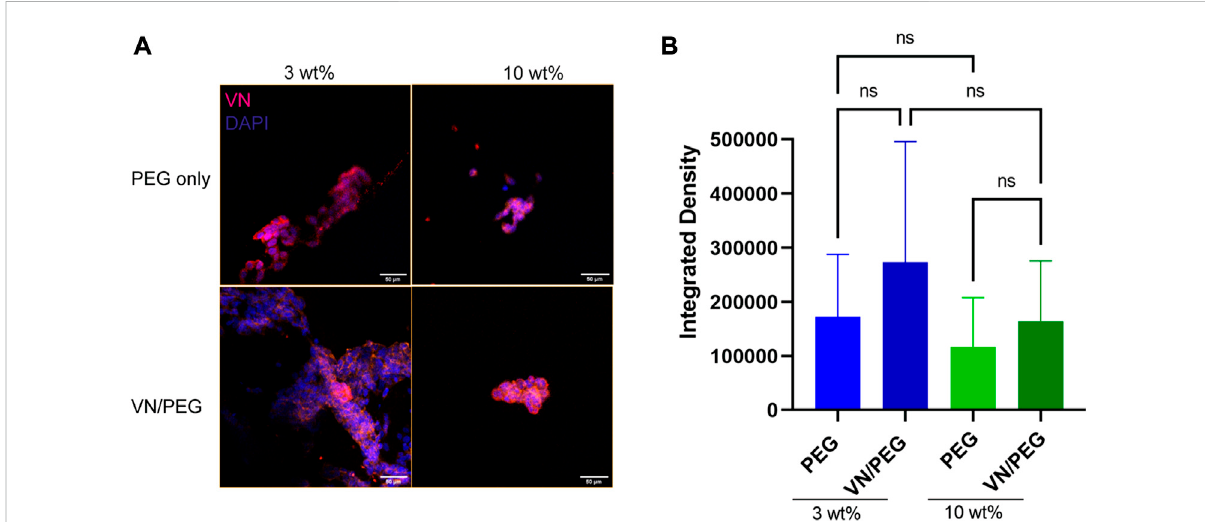
FIGURE 5 Distribution of VN secreted by the cells in 3D PEG and VN/PEG hydrogels. Immuno fl uorescence images of SK-N-BE (2) cultured for 7 days in 3 and 10 wt% PEG and VN/PEG. Images show nuclei (blue) and VN (magenta) (scale bar 50 µm). (B) . Immuno fl uorescence quanti fi cation of VN secreted by cells in 3 and 10 wt% PEG with/without VN. We have represented in the graph the Integrated density (total raw intensity per image normalized by cell area). A total of 15 images (3 replicates, 5 images each) were taken per sample